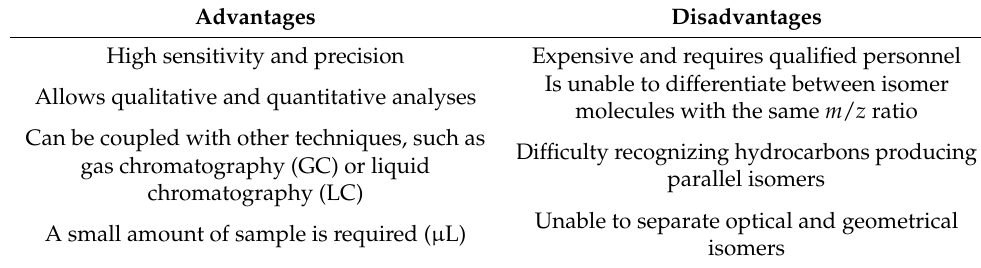
Table 2. Advantages and disadvantages of mass spectrometry